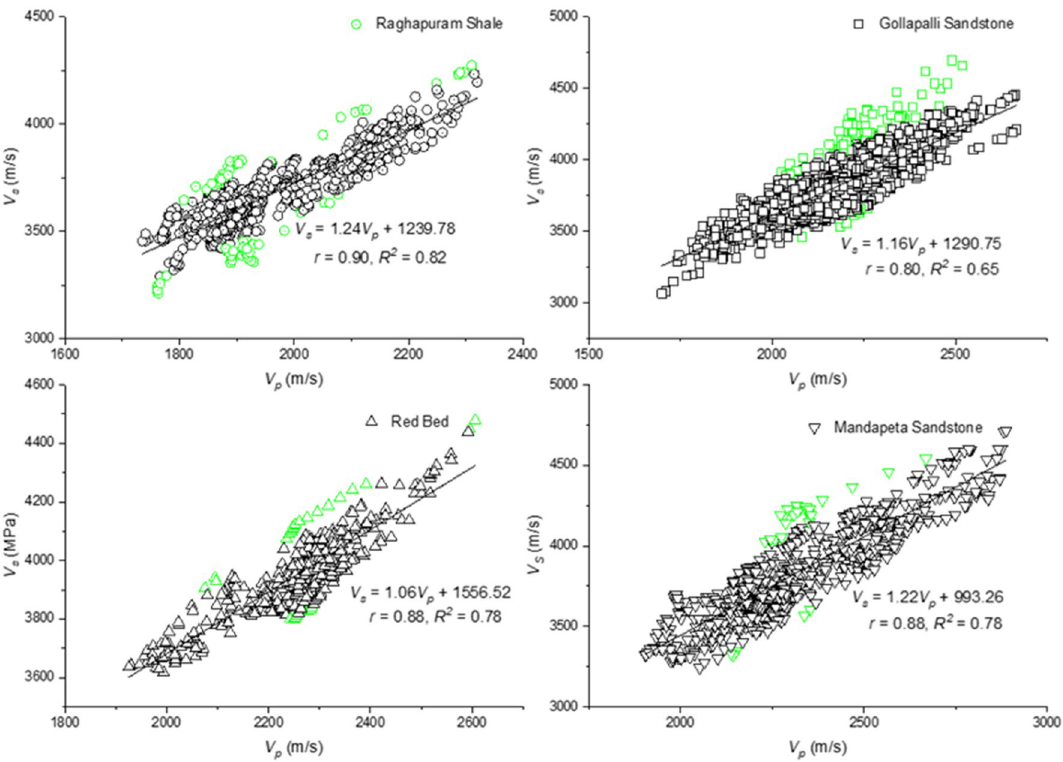
Figure 6. Regression model developed for V p and V s for different formations of the selected